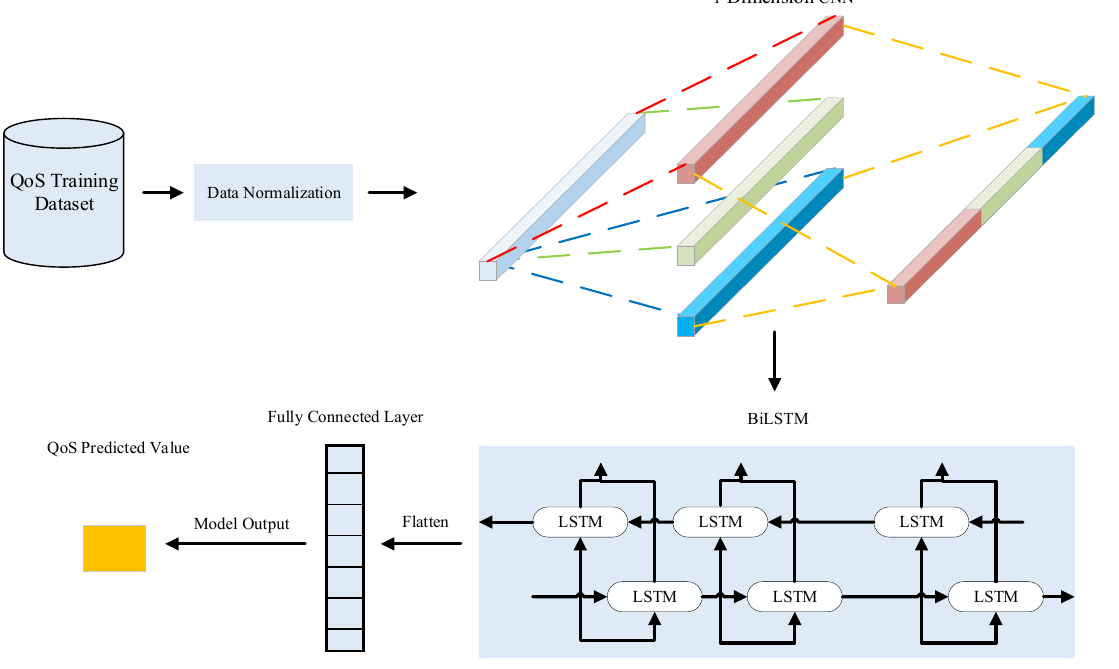
Figure 7. CNN-BiLSTM Neural Network Structure.